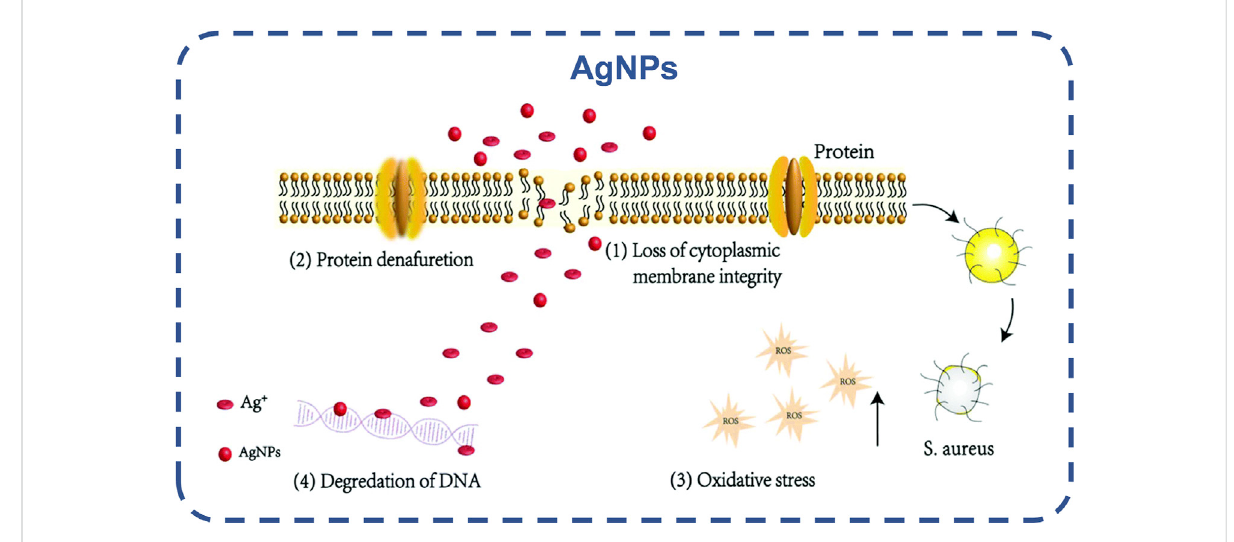
FIGURE 8 Schematic diagram of the potential antibacterial mechanism of AgNPs and Ag (Ding et al., 2020). Copyright 2020, Biomater